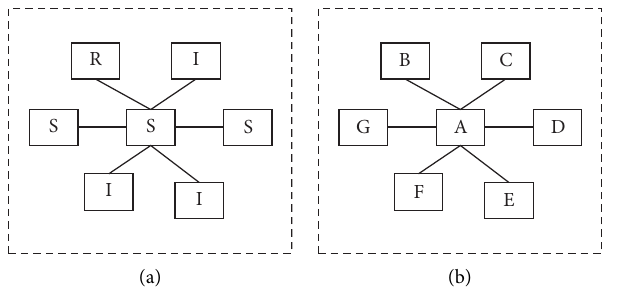
Figure 9: Individual information interaction mode in polarization model. (a) Information interaction Mode (epidemic model). (b) Information interaction mode (one-to-many mode).